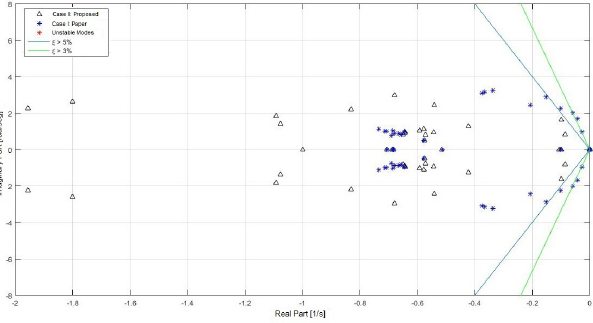
Figure 25. Eigenvalues in light load operation condition.